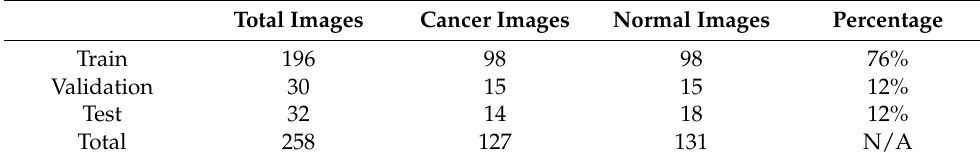
Table 1. Training, validation, and testing datasets overview. Total